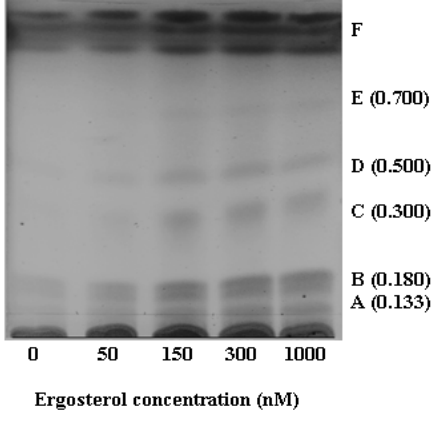
Figure 3. HPTLC image indicating differences between the DLLME chloroform extracts from control (non-treated) and treated cells. Chromatography was performed with chloroform: methanol (19:1, v/v) and detection with vanillin/sulphuric acid